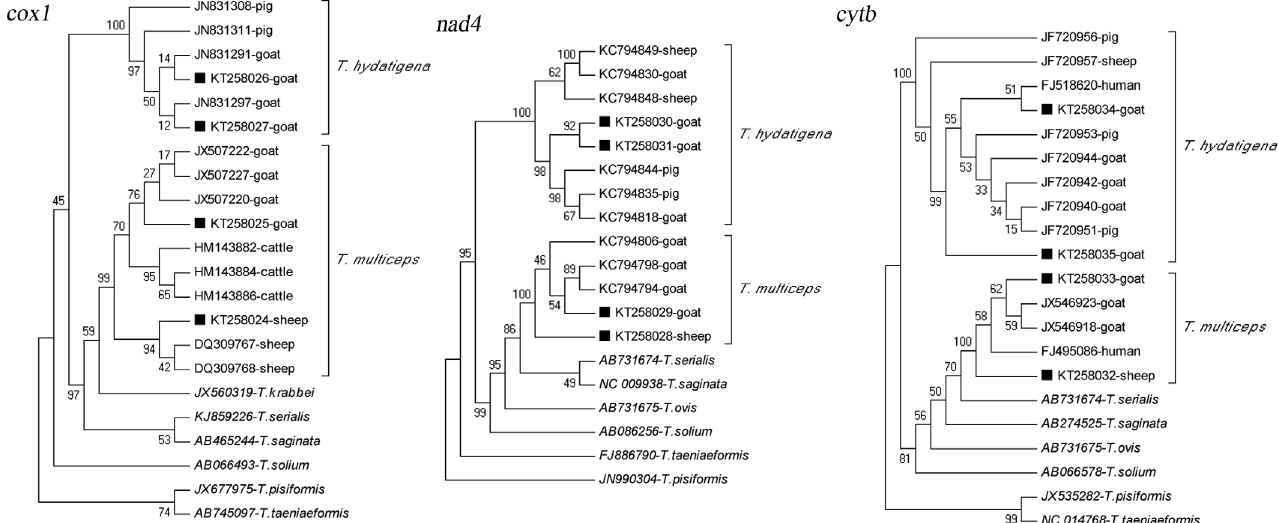
Figure 1. Phylogenetic relationship of T. multiceps and T. hydatigena isolates obtained in the present study and other T. multiceps and T. hydatigena isolates as well as other members of the genus Taenia as inferred by neighboring-joining analysis of the cox1 , nad4 and cytb gene sequences based on genetic distances calculated by the Kimura 2-parameter model. The reliability of these trees was assessed using a bootstrap analysis with 1,000 replicates. The GenBank accession number and the host of origin are given for each isolate of T. hydatigena or T. multiceps . Black squares indicate the sequences of T. hydatigena or T. multiceps from the present